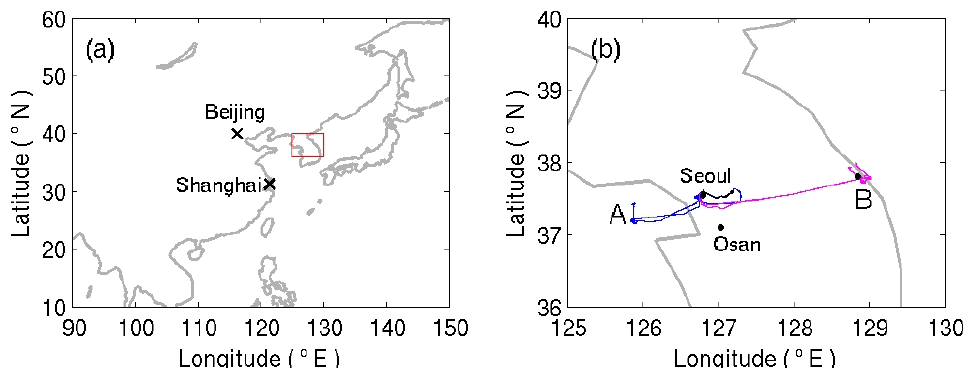
Figure 1. ( a ) Geographical locations of an experimental area with ( b ) an enlarged area of the Korean Peninsula. A and B in ( b ) show the Yellow Sea and Gangneung roughly, respectively. In ( b ), the blue lines indicate the flight patterns for the Yellow Sea and Seoul and magenta lines indicate the flight patterns for the Gangneung area parallel to the coastline. The black line in ( b ) shows the Han River, which flows across Seoul, the capital of South Korea. Seoul and upper-sounding locations (Osan and Bukgangneung) are overlaid as black dots in ( b ). Table 1. Flight Summary.